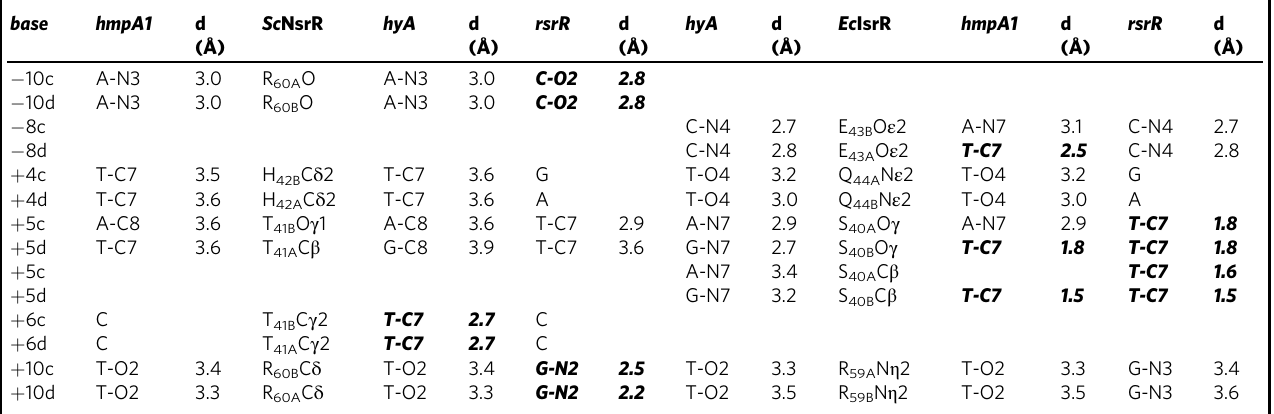
Table 2 NsrR and IscR base speci fi city for different operator